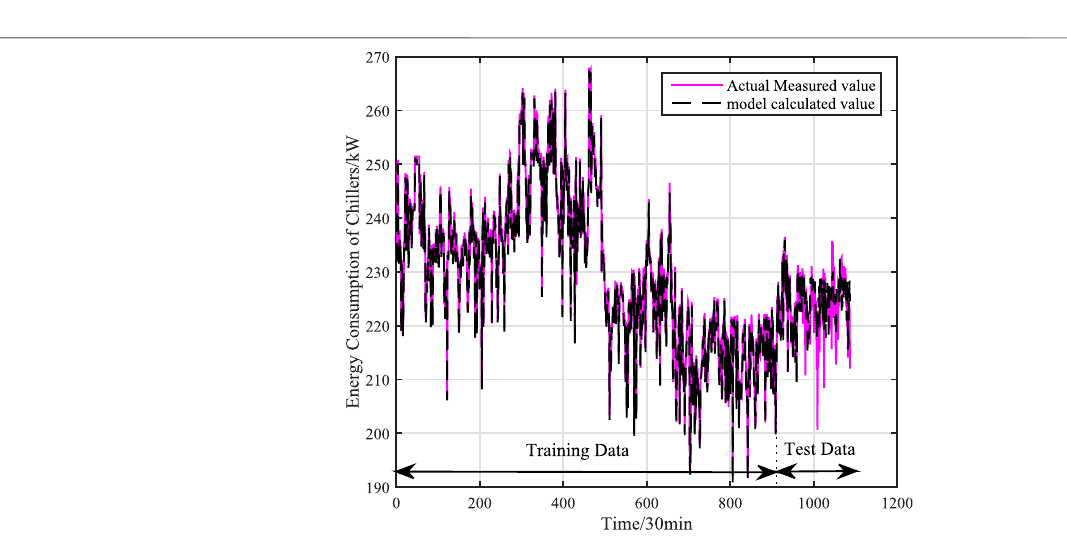
Frontiers in Energy Research |